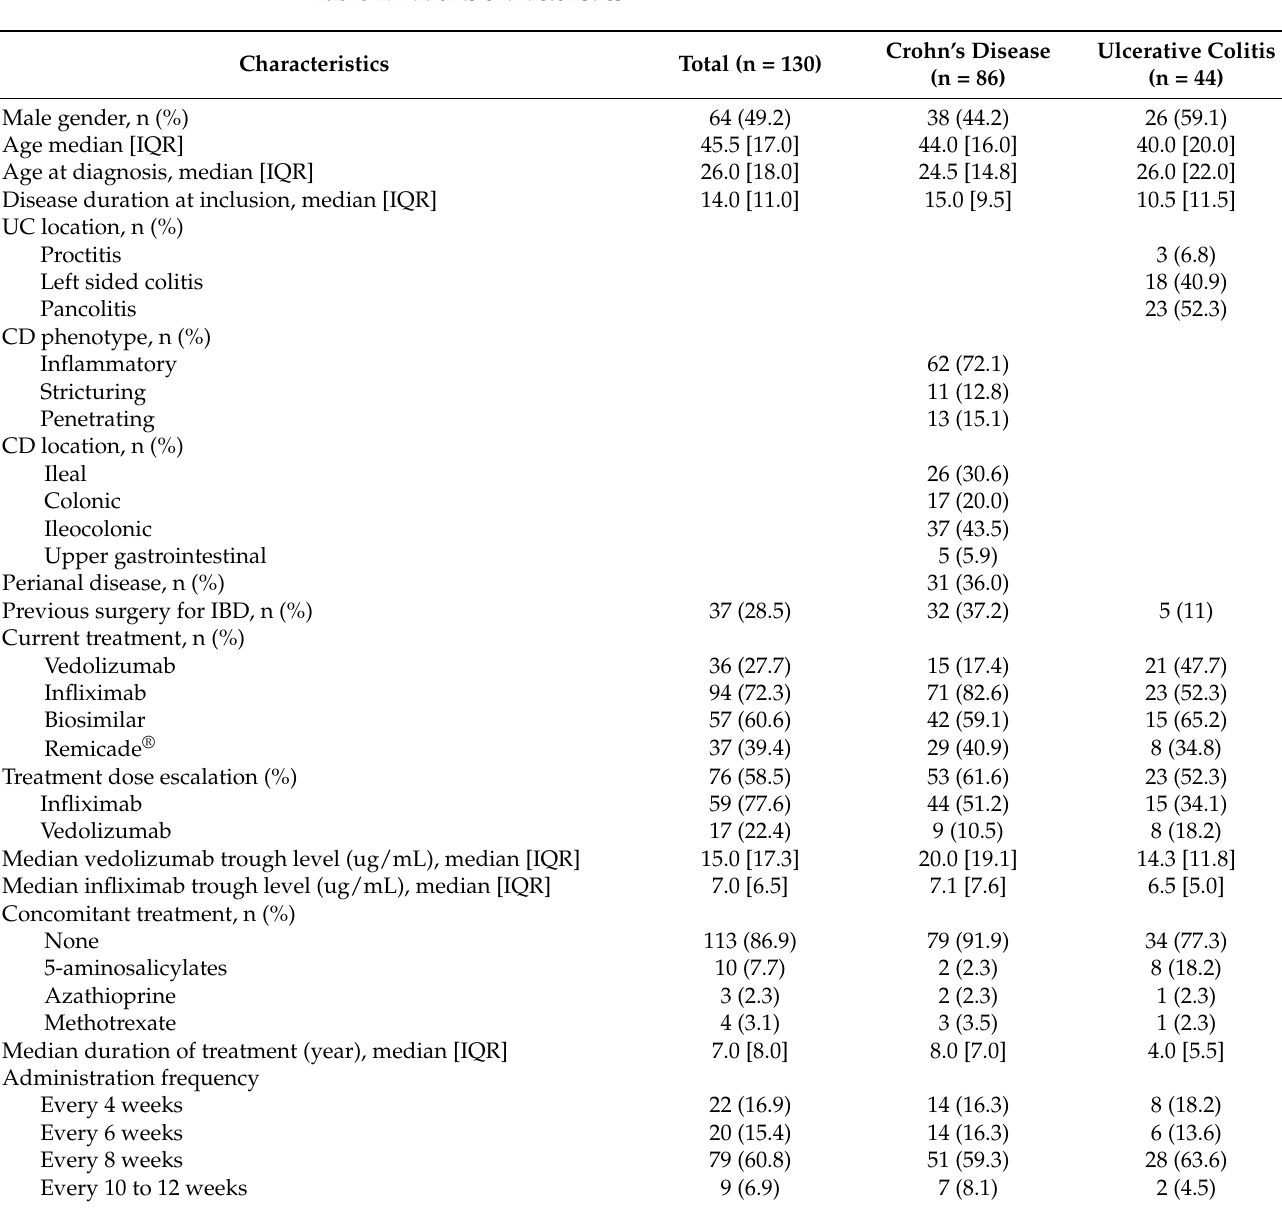
Table 1. Patients